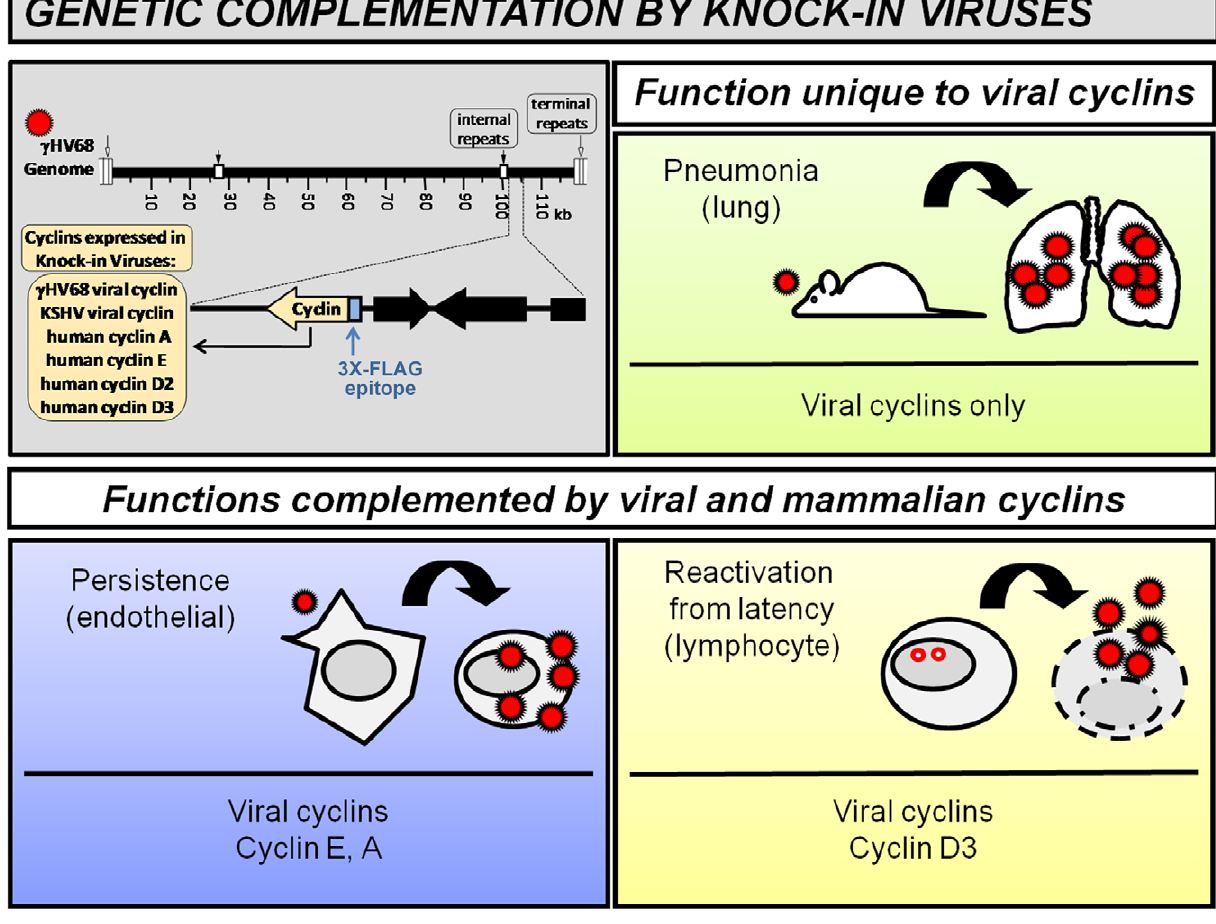
Figure 5. Proposed model for viral cyclin requirements in virus infection. Recombinant knock-in viruses with various viral or mammalian cyclins expressed from the endogenous gHV68 viral cyclin locus are depicted at upper left. Genetic complementation analysis of this panel of viruses demonstrated that the viral cyclins of gHV68 and of KSHV are functionally conserved and are unique in their ability to support all cyclin-dependent aspects of infection, depicted as three different panels. Further, mammalian cyclins able to function in virus infection comprised two genetically distinct groups, based on their ability to complement either persistent infection in endothelial cells (lower left) or reactivation from latency in lymphocytes (lower right). Finally, we propose that the unique capacity of the viral cyclins to support acute virus production and lethal pneumonia in the lungs of immune deficient mice does not reflect another distinct genetic requirement of viral cyclins. Rather, we hypothesize that both persistent infection and reactivation from latency contribute to optimal acute virus production in the lungs (upper right), as indicated by the combination of blue and yellow.